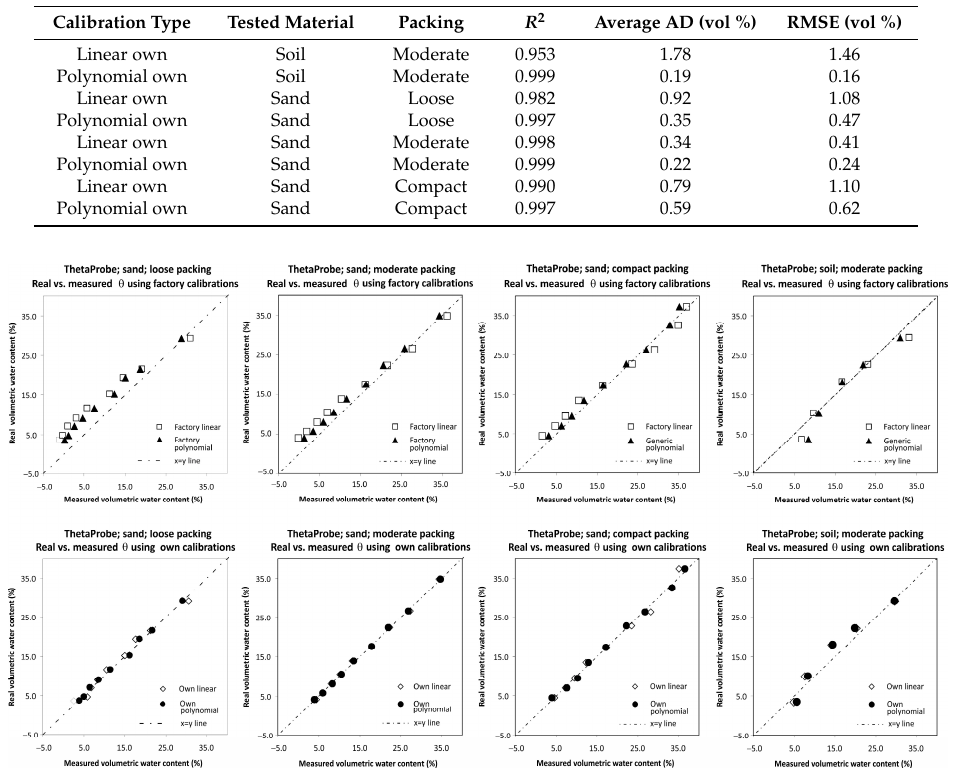
Figure 3. Graphical comparison of the real volumetric water contents obtained on the basis of the gravimetric method and volumetric water contents measured by ThetaProbe using factory and our own linear and polynomial calibration equations.